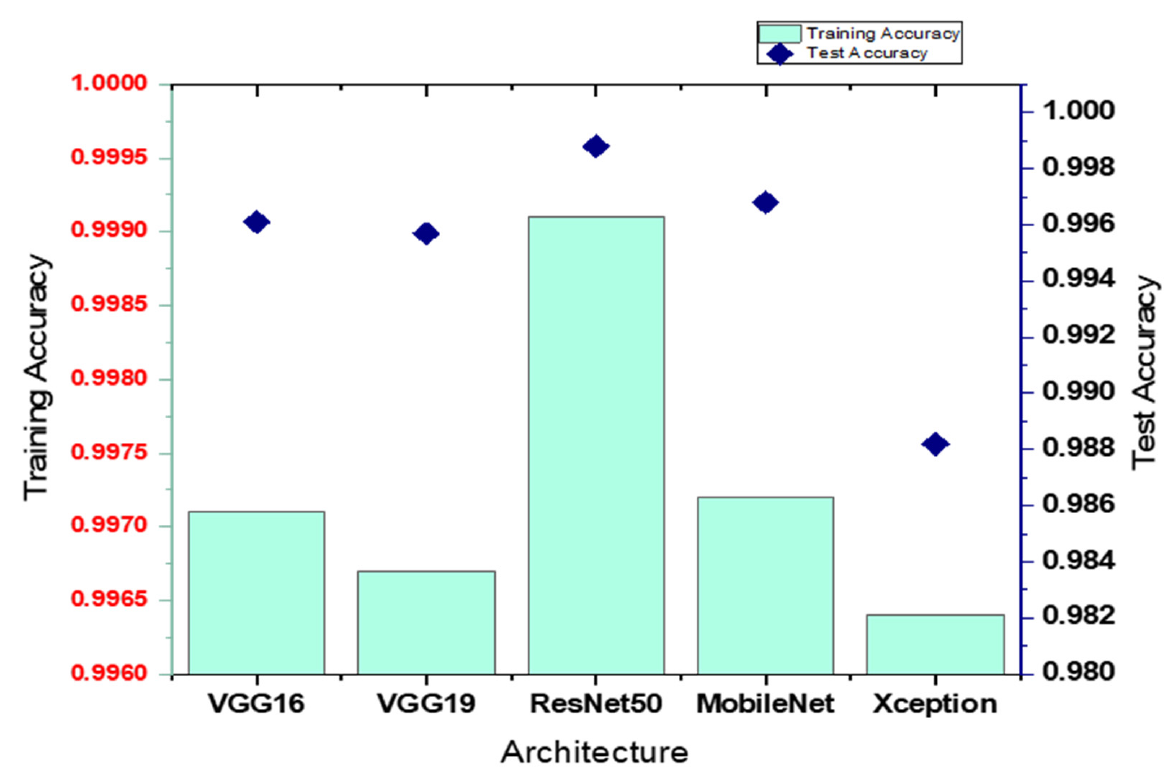
Figure 20. Comparison of training and test accuracies of all five architectures.